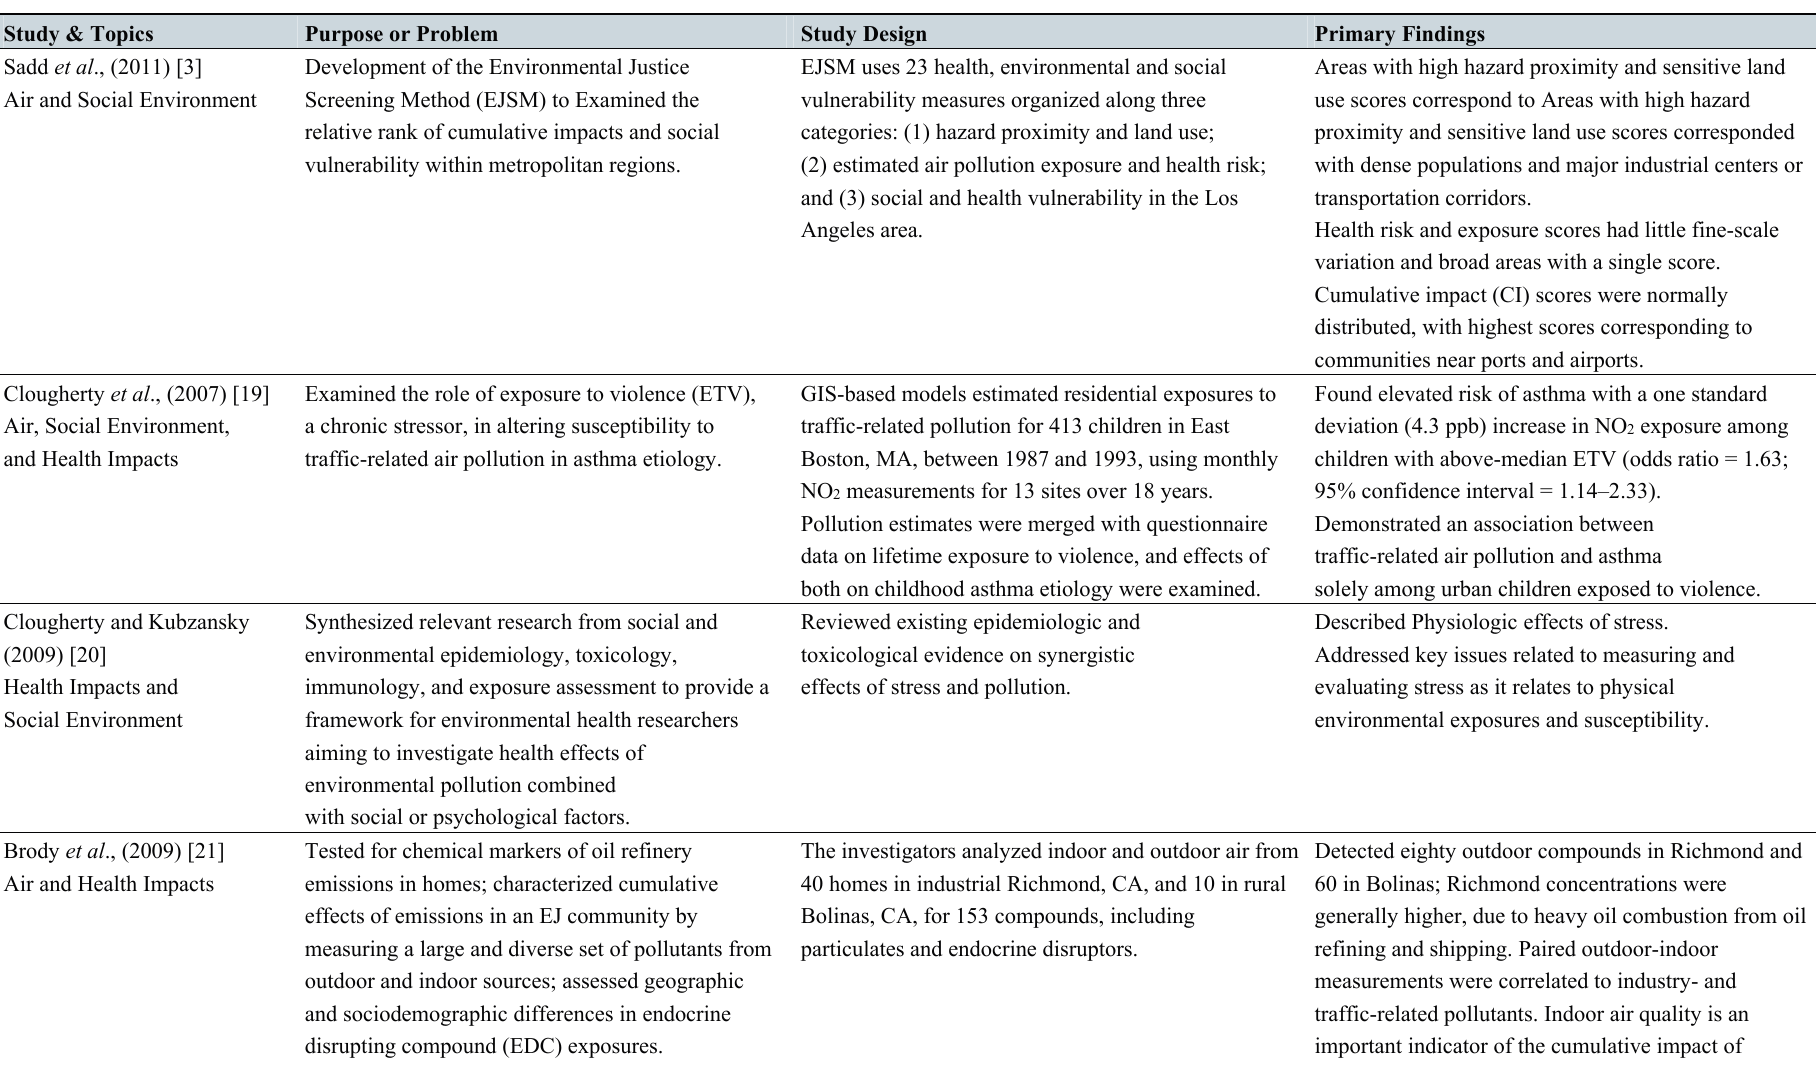
Table 1. Overview of community based projects involving quantification of cumulative